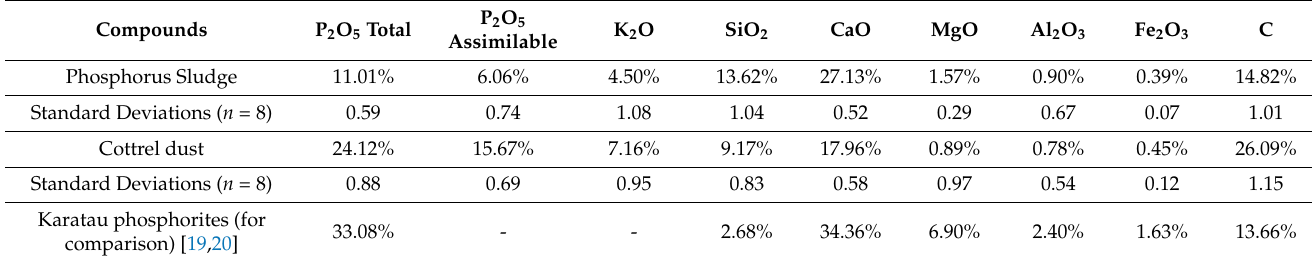
Table 1. Average chemical composition of phosphorus sludge and cottrel dust.